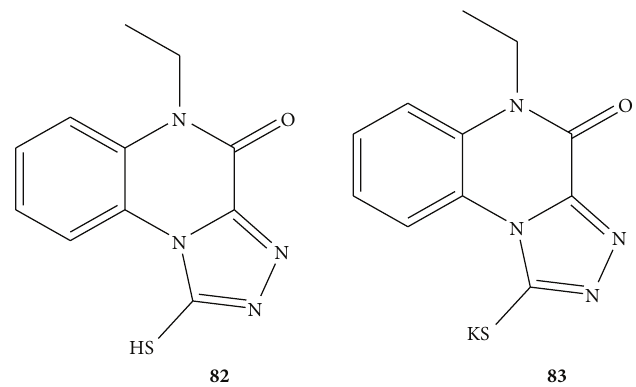
Figure 34: Chemical structures of compounds tested.